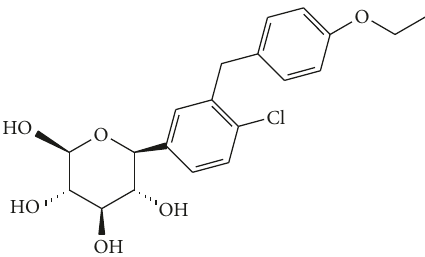
Figure 1: Chemical structure of dapagliflozin (DAPA).